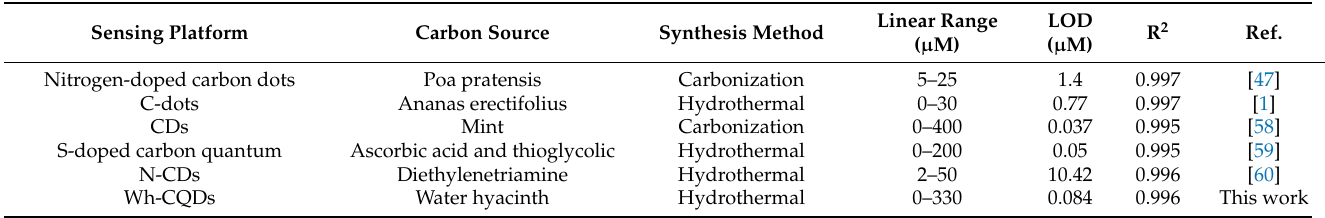
Table 1. Comparison of the Fe 3+ detection sensitivity between the wh-CQDs and other reported CQDs.